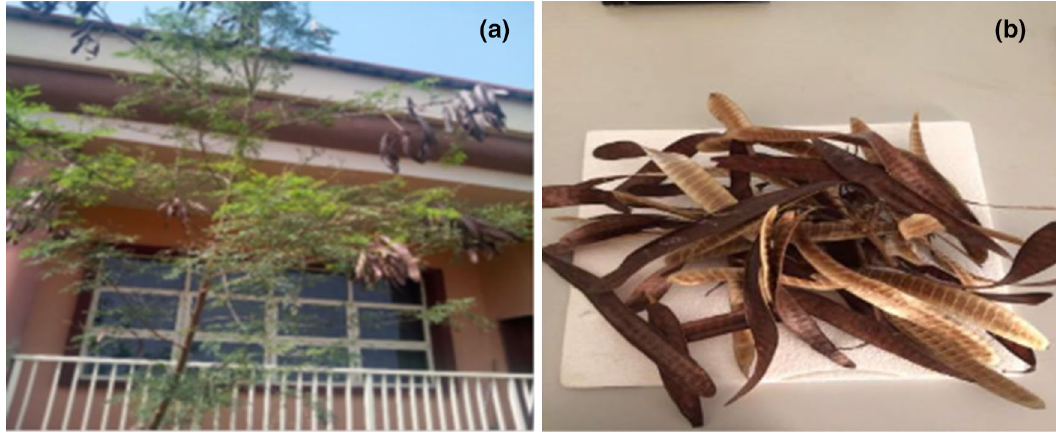
Fig. 1 a Leucaena leucocephala tree and b Leucaena leucocephala seed